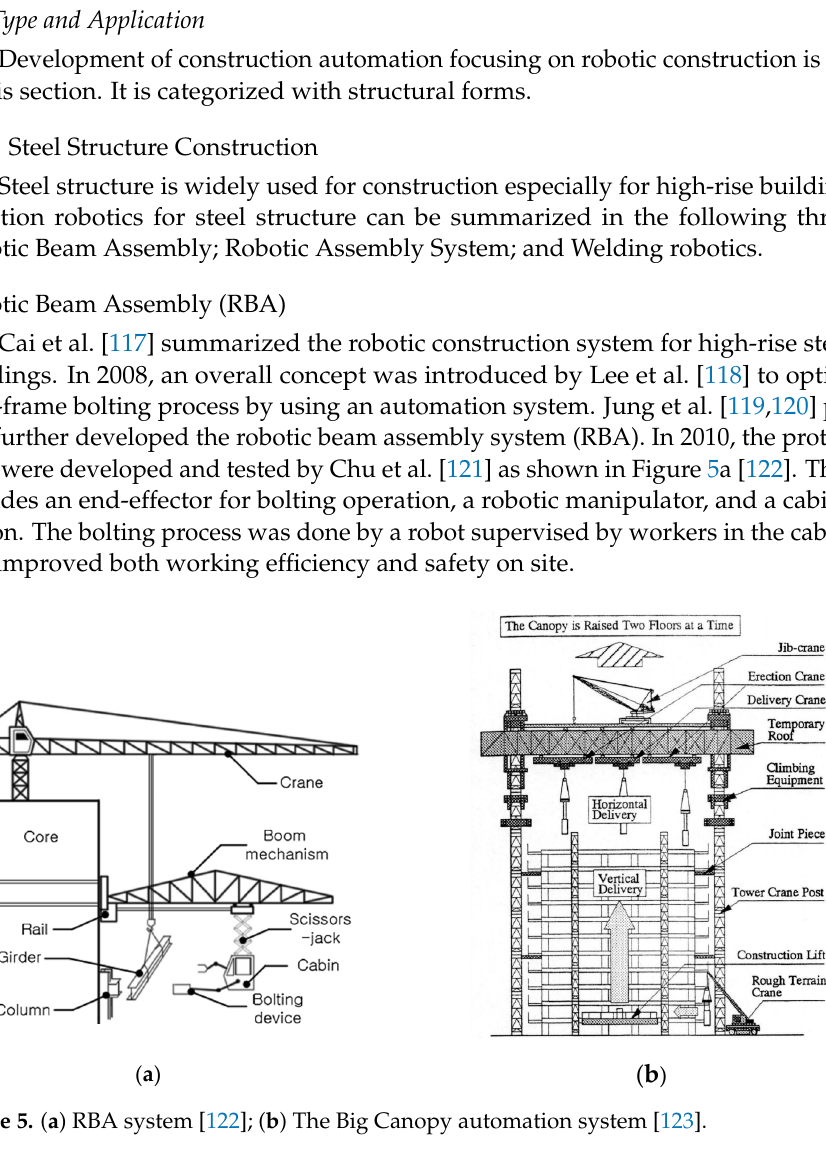
( b ) Figure 6. Welding robot ( a ) Mobile Welding robot; ( b ) Welding robots attaching on structure [125,126,128].